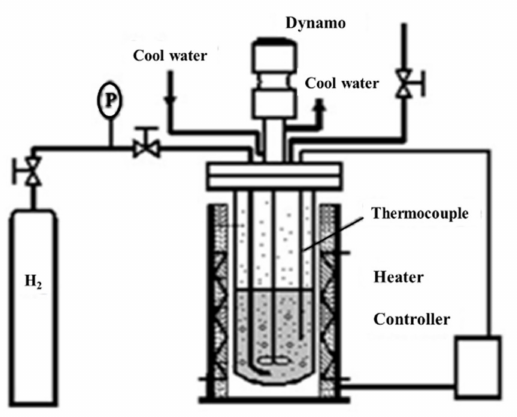
Figure 2. Schematic diagram of experimental